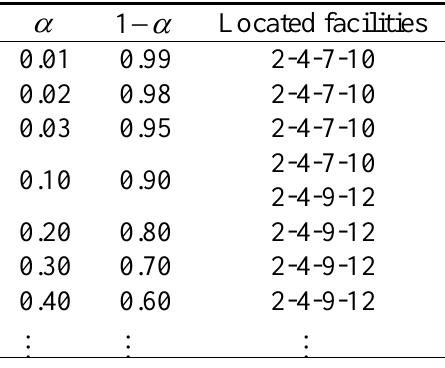
Table 2. Results of computational